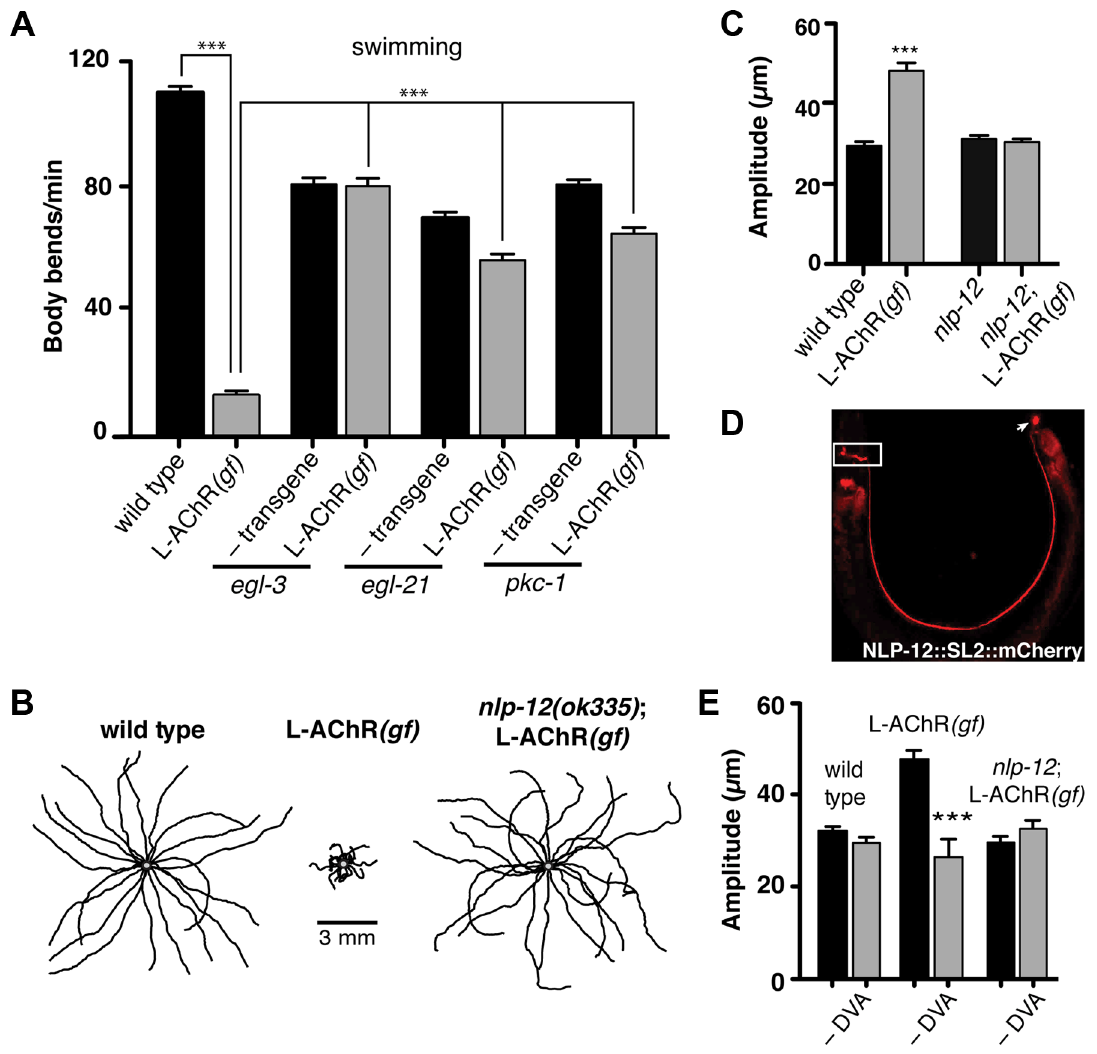
Figure 2. Locomotory phenotypes associated with L-AChR (gf) expression require neuropeptide signaling. ( A ) Average body bends/min measured in liquid for the genotypes indicated. The strong locomotory defects of egl-3 and egl-21 mutants prevented analysis of L-AChR( gf ) effects on agar (Fig. S3A, B). Mutation of pkc-1 normalized the locomotor effects of L-AChR( gf ) in both liquid and on agar (Fig. S3C–E). ( B ) Movement trajectories of wild type, L-AChR (gf), nlp-12 ;L-AChR (gf) animals as indicated. Each black line shows the trajectory of one animal monitored for 45 s on food. ( C ) Average body bend amplitude for the genotypes indicated. Each bar represents the mean ( 6 SEM) of values calculated from recordings of at least 15 animals. For (A) and (C) ***, p , 0.0001 by ANOVA with Sidak’s post-hoc test. ( D ) Wide-field epifluorescent image of an adult animal expressing nlp-12::SL2::mCherry . The image is oriented with the head to the left. White rectangle: nerve ring. Arrow: DVA cell body. ( E ) Average body bend amplitude for the indicated genotypes and effects of DVA ablation (–DVA). Ablations were performed on L2 stage animals. Body bend amplitude was measured from recordings of young adult animals 2 days following laser ablation. Error bars indicate mean ( 6 SEM) of at least 8 animals. ***, p , 0.0001 student’s